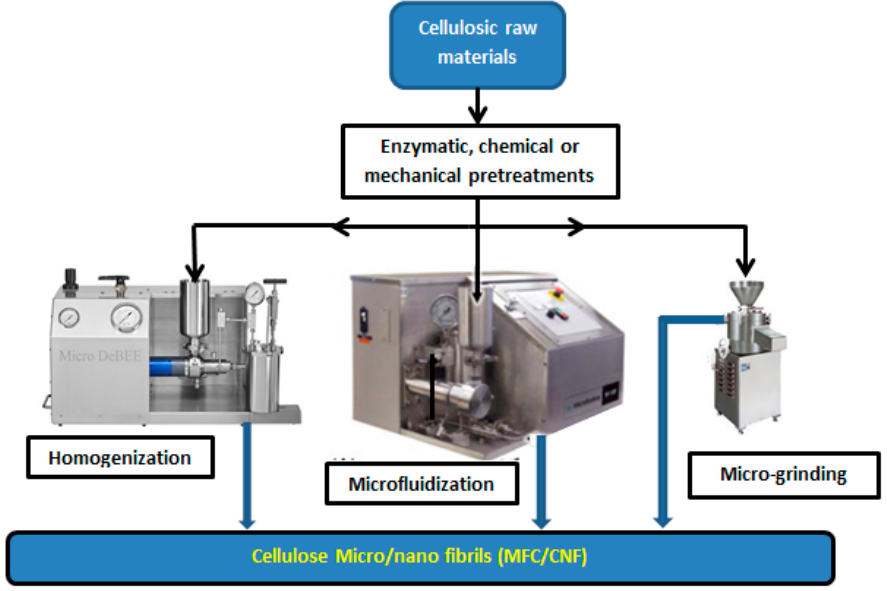
Figure 2. Phases for microfibrillated cellulose (MFC) production.